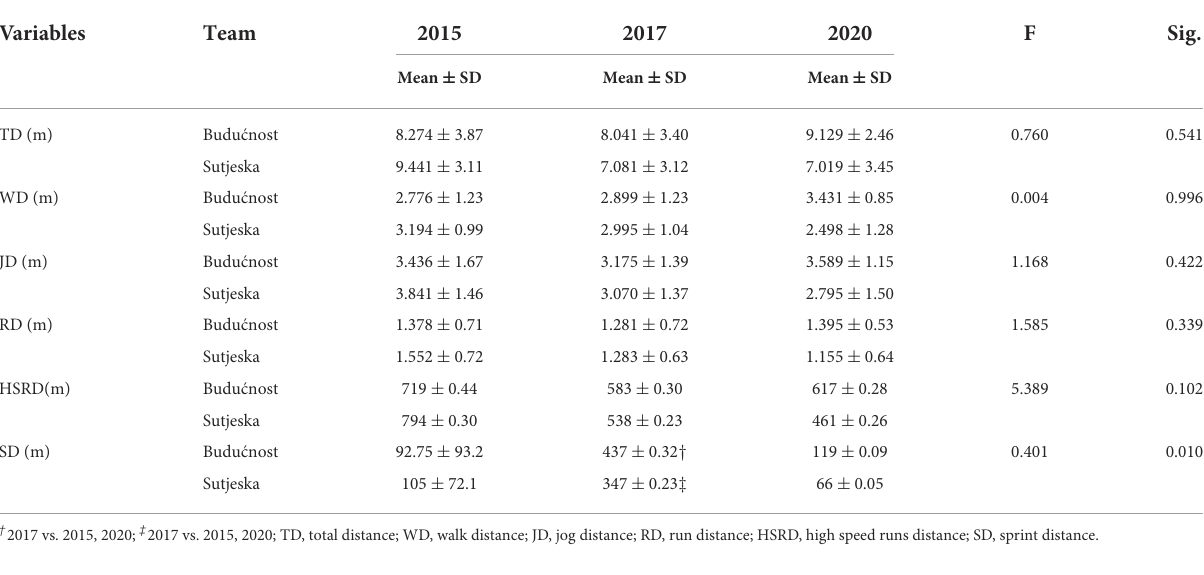
TABLE 1 Descriptive data of performance running.